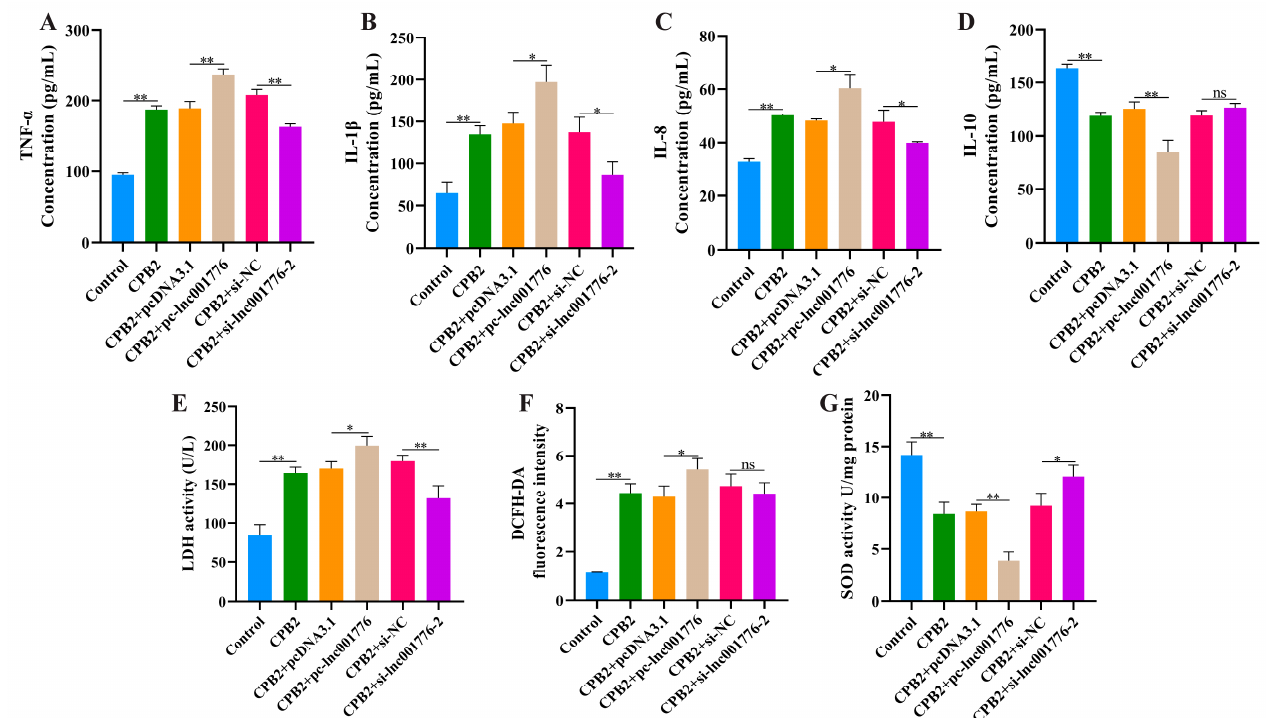
Figure 3. Overexpression of lnc001776 enhanced CPB2 toxin-triggered in fl ammatory damage in IPEC-J2 cells. ( A – D ) TNF- α , IL-1 β , IL-8 and IL-10 levels via ELISA. ( E ) LDH activity. ( F ) ROS level. ( G ) SOD activity. ns: not significant. * p < 0.05, ** p < 0.01.